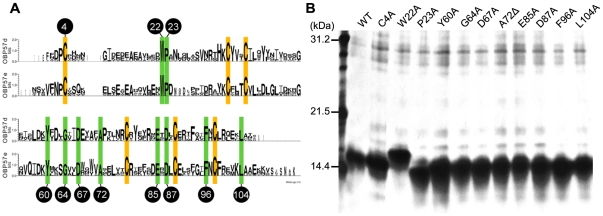
Site-directed mutagenesis of the evolutionarily conserved amino acids.(A) Aligned sequence Logo representation of OBP57d and OBP57e. Among the 16 evolutionarily conserved sites (highlighted by yellow for the OBP signature cysteins and green for the others) [19], 11 were selected for site-directed mutagenesis in Dmel\OBP57d (indicated by black circles; numbers indicate the position in Dmel\OBP57d). (B) Expression of the 11 mutated OBPs in the insoluble cytoplasmic fraction was confirmed by SDS-PAGE.